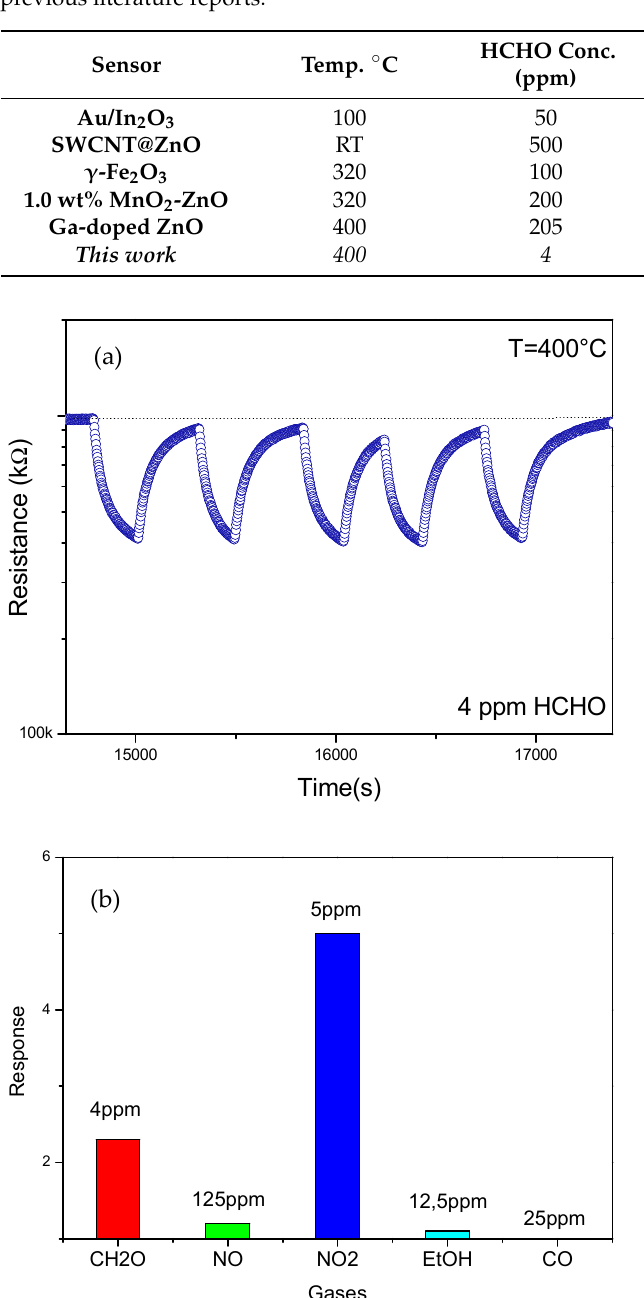
Table 1. Sensing characteristics of 3Al,3Ca doped ZnO sensor towards HCHO compared with previous literature reports.